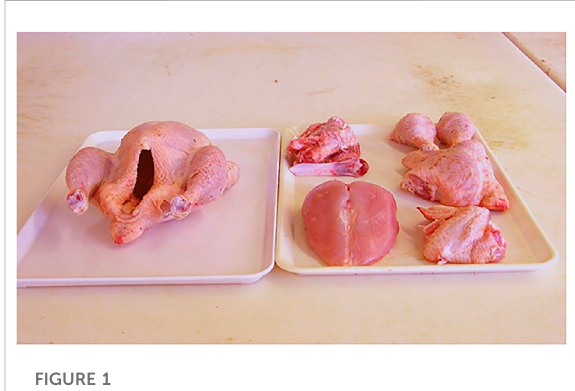
FIGURE 1 Illustration of dissected carcass to determine slaughter